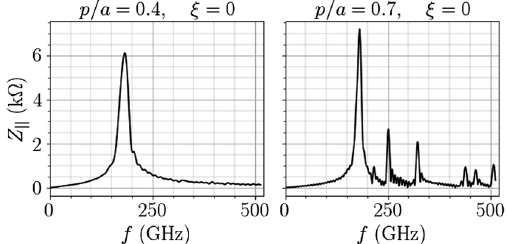
FIG. 13. Comparison of wake impedance for maximum radii structures with p=a ¼ 0 . 4 (left panel) and p=a ¼ 0 . 7 (right panel) and aperture ratio a= λ ¼ 0 . 60 . The HOMs are seen as additional peaks for the larger period structure on the